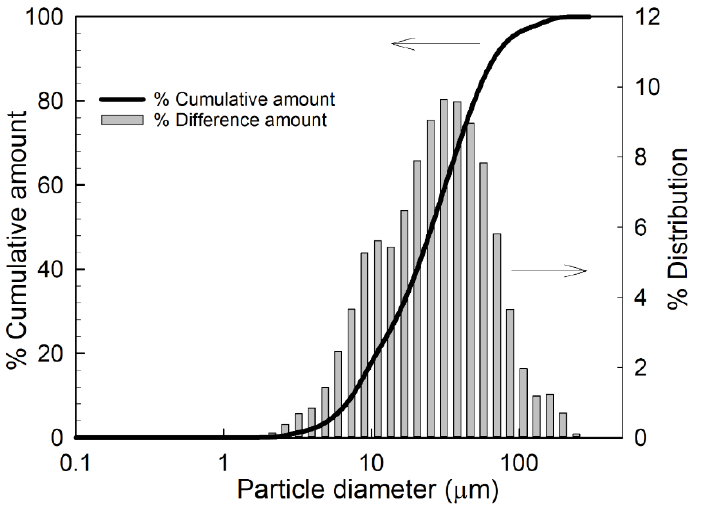
Figure 1. Particle size distribution for 90:10 CMA:PEG400DA PCBAE microparticles analyzed